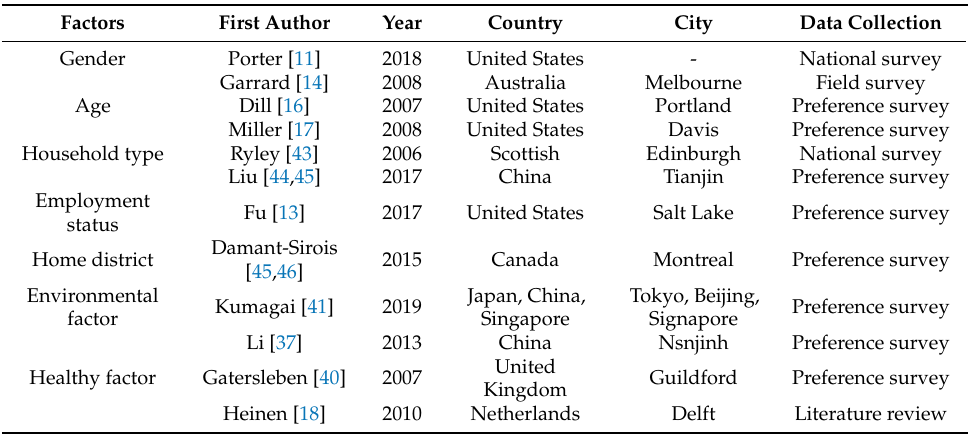
Table 1. Summary of factors in previous